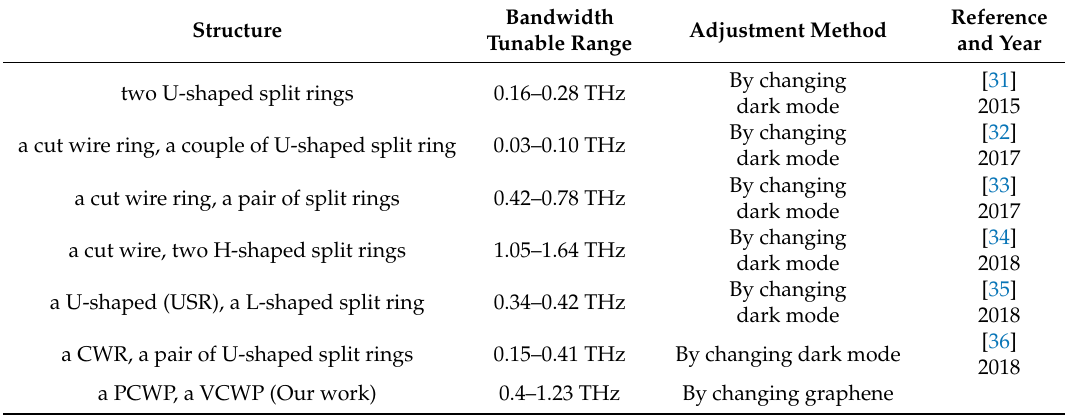
Table 1. The performance comparison of di ff erent EIT-like metamaterial structures.